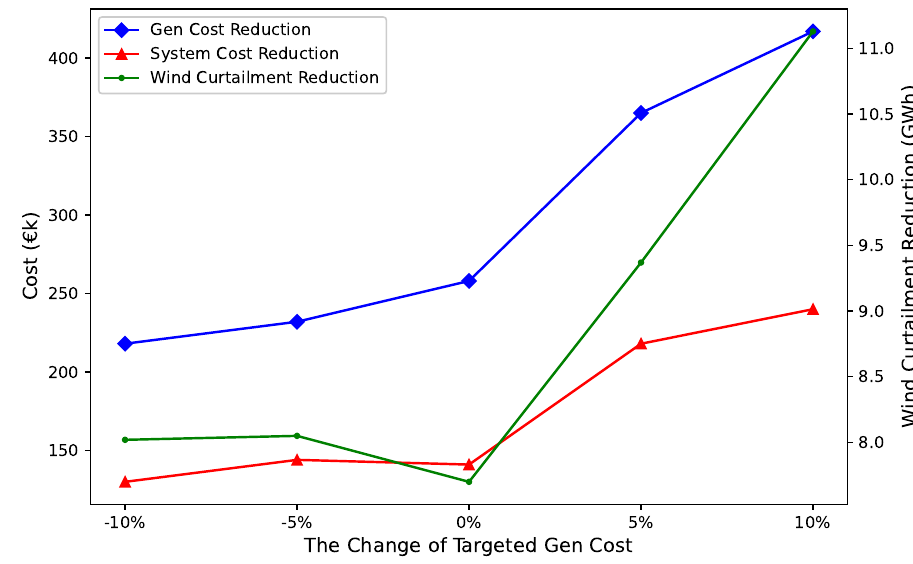
Figure 16. The generator costs sensitivity analysis